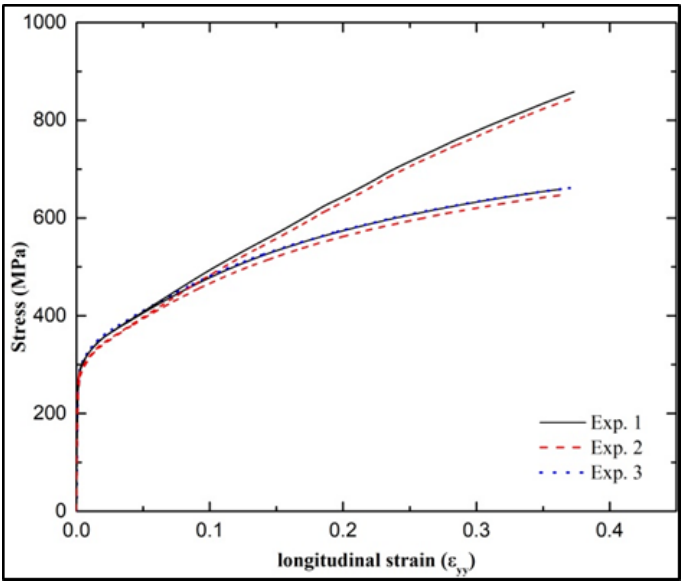
Figure 4. Nominal and Cauchy stress vs. logarithmic strain for reproducible experiments .